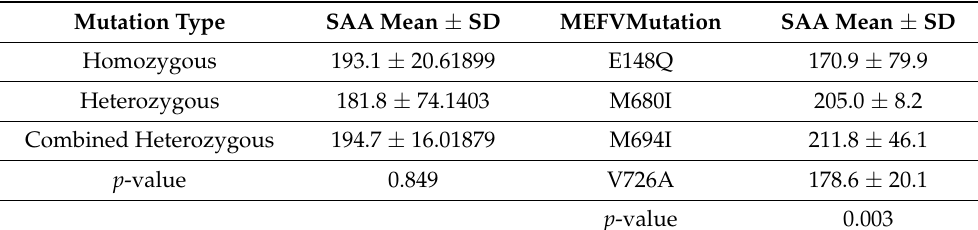
Table 3. Comparison between SAA levels and mutation type, and different